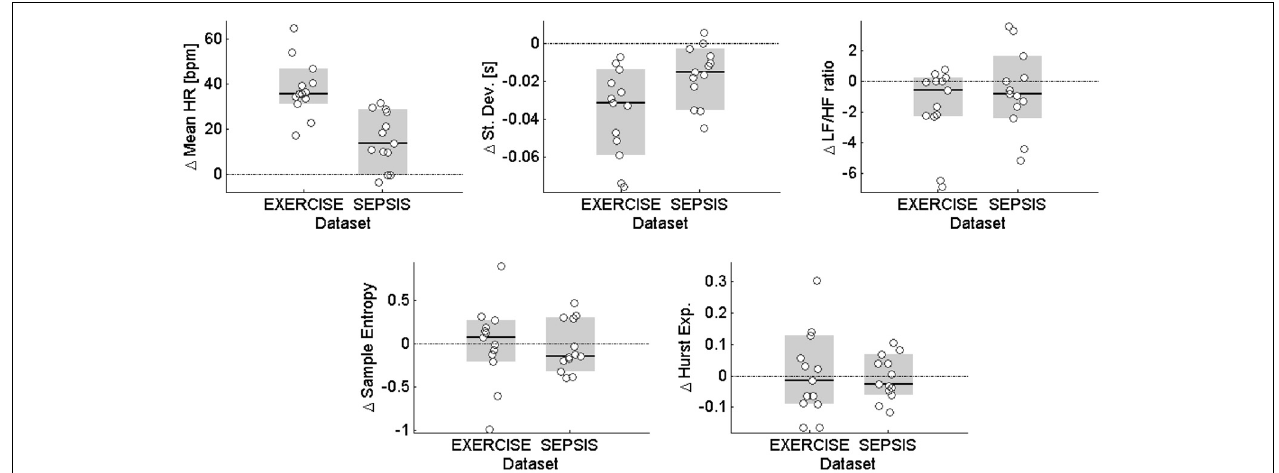
described in Table 3 . The black solid line is the median of the dataset, and the gray area identifies the 95% confidence intervals for the median. The horizontal dash-dot lines highlight the lines of no change from baseline to stress.